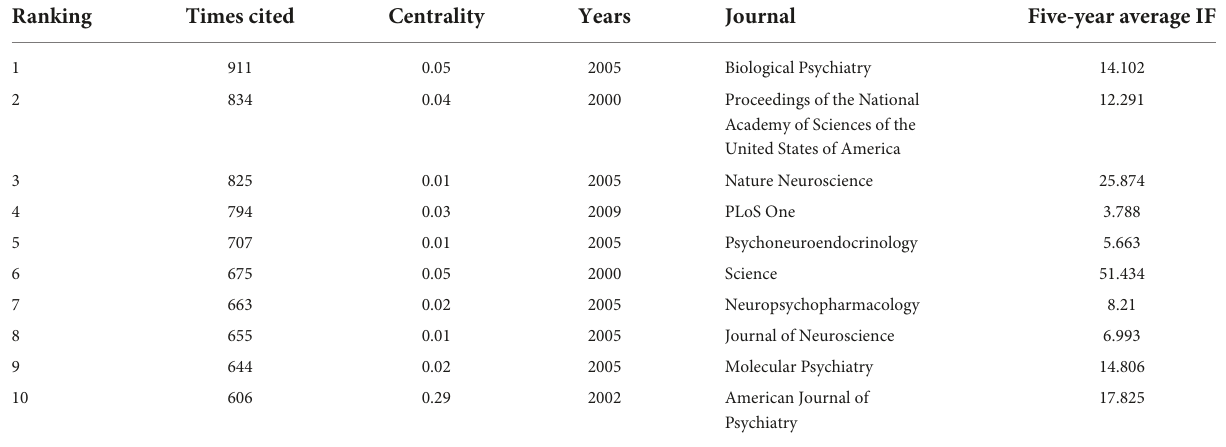
TABLE 3 The top 10 co-cited